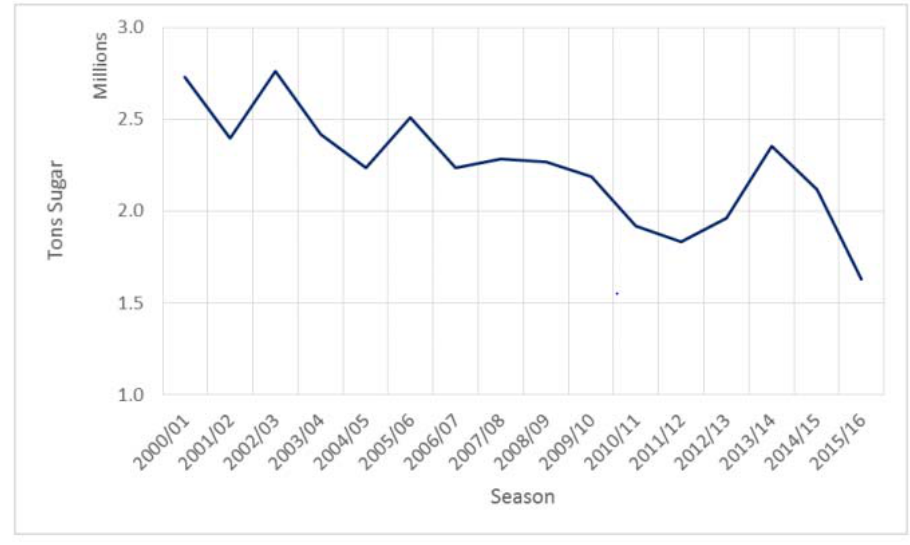
Fig. 1. Indicates the declining trend in the large-scale production of sugarcane production and particularly sucrose yields Source: adopted from Harris